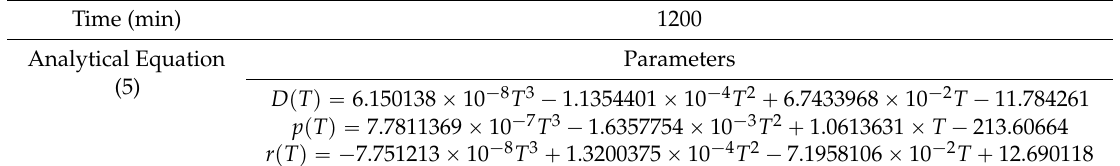
Table 2. Creep modeling data: X6CrNiTi18-10 steel. Material: X6CrNiTi18-10